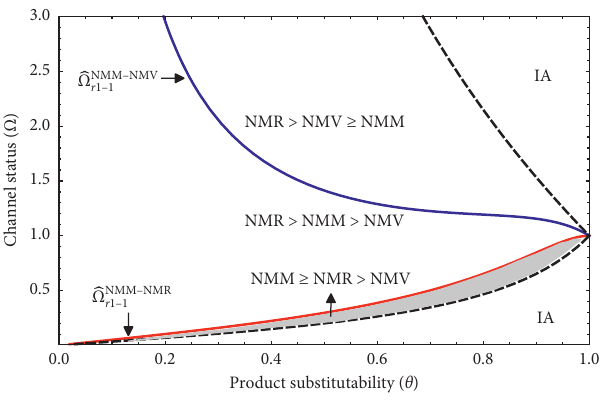
Figure 2: Comparison of retailer 1 profits under MS.